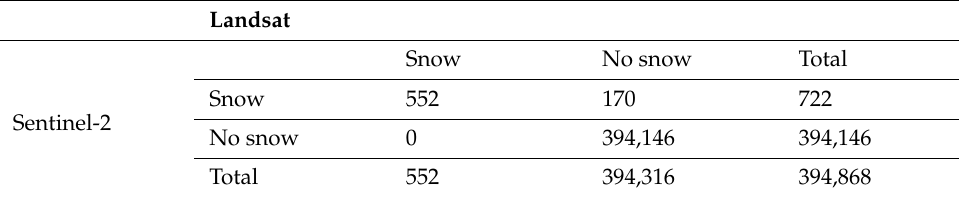
Table 3. Confusion matrix showing accuracy of Landsat 8 25 June 2018 satellite image in classifying snow-covered pixels, using 25 June 2018 Sentinel-2 image for validation. All numbers are pixel counts. User accuracy is 100% and producer accuracy is 76.5%.